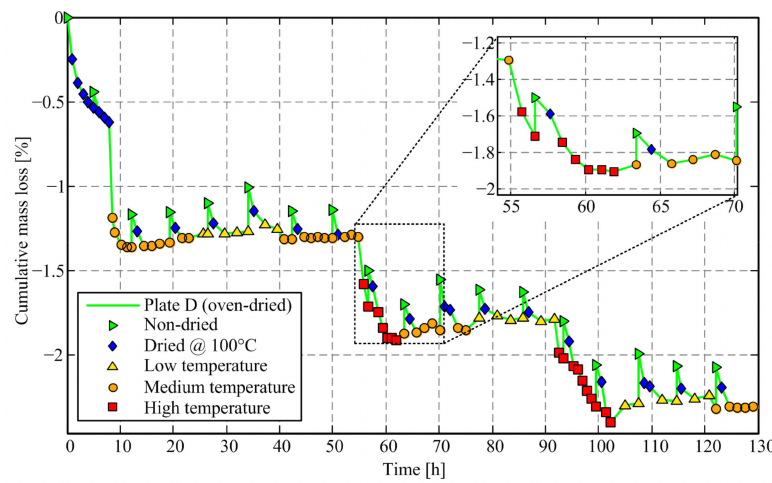
Figure 7. Comparative time response of cumulative mass loss of oven-dried friction plate